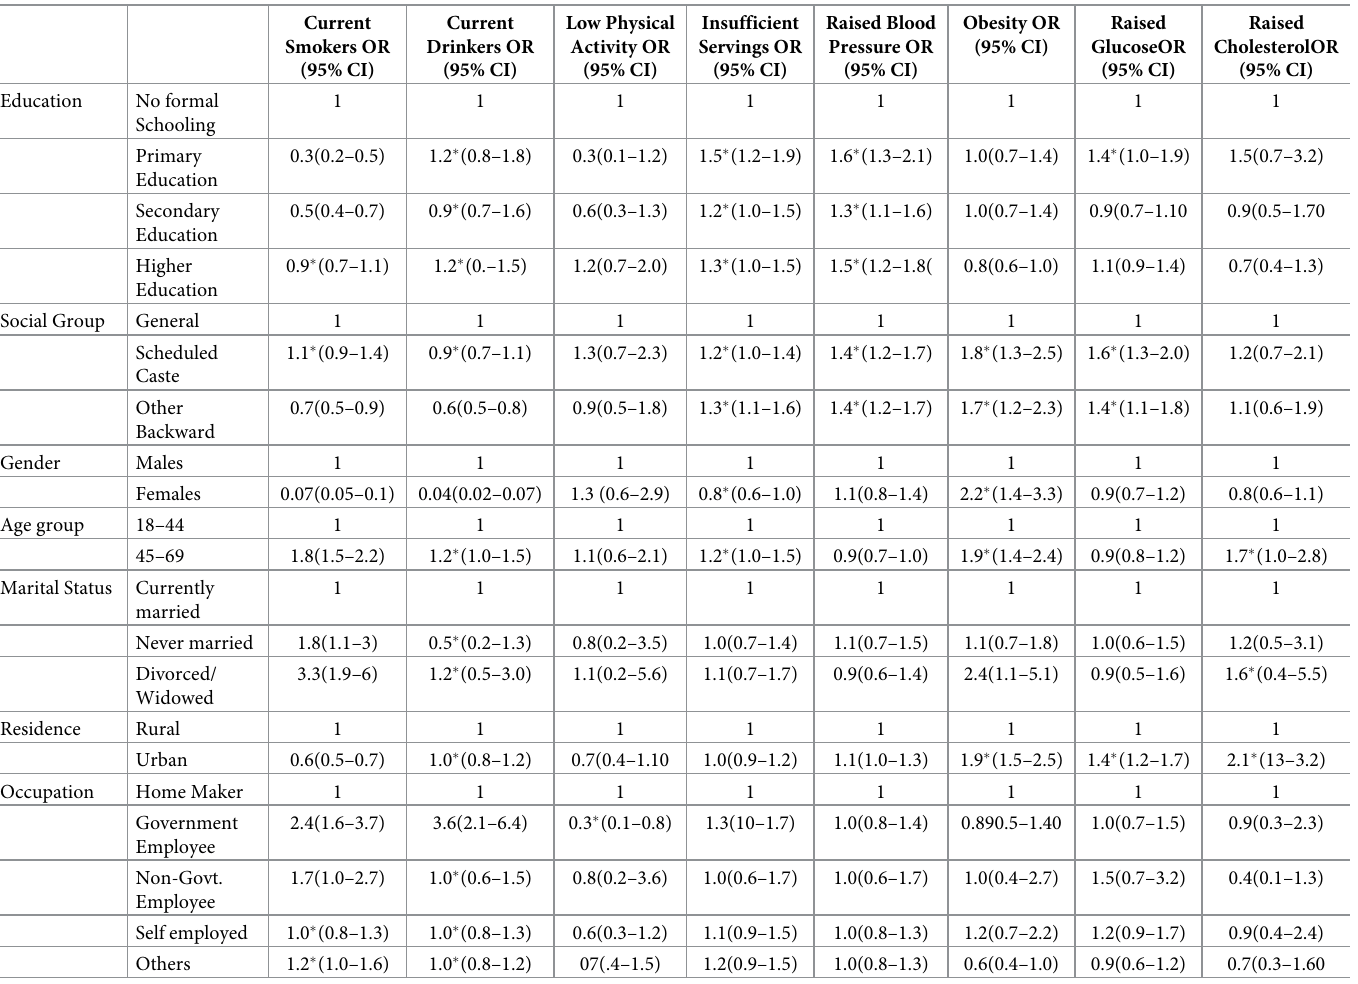
Table 6. Determinants of NCD risk factors among aged 18–69 years in the State of Haryana,